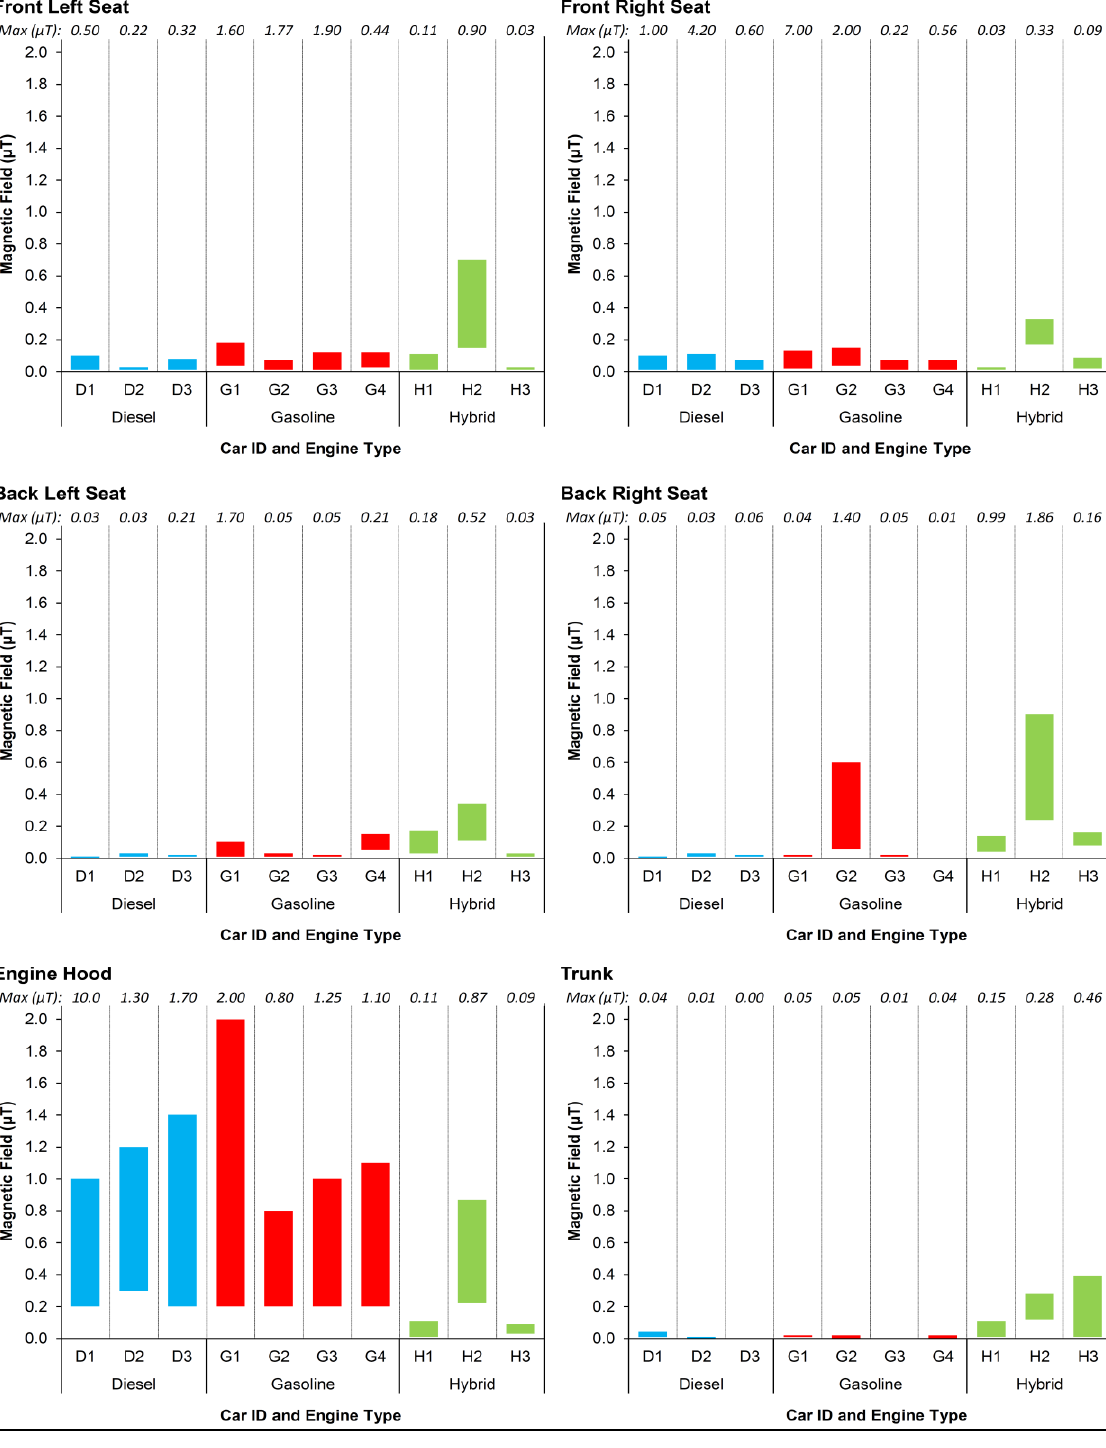
Figure 1. Typical range of MF spot measurements at 6 locations by car and engine type